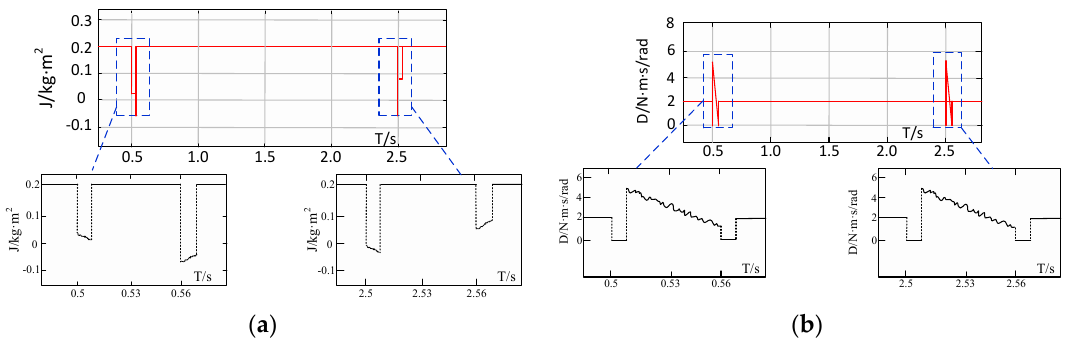
Figure 14. The variation of virtual inertia and damping coefficient: ( a ) virtual inertia; ( b ) damping coefficient.